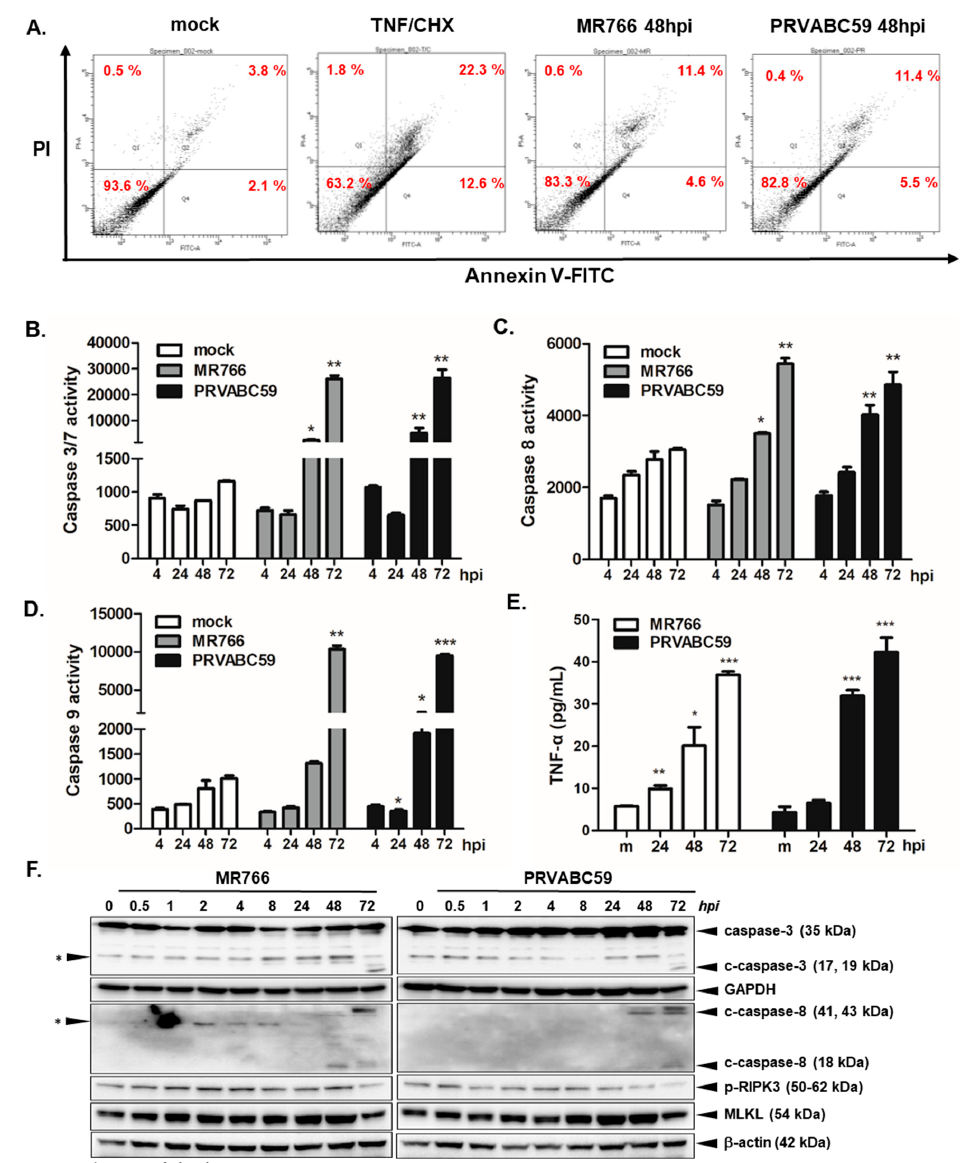
Figure 2. Caspase activity during Zika virus (ZIKV) infection of hNPCs. hNPCs were either stimulated with TNF- α and cycloheximide (TNF/CHX) or infected with mock or ZIKV at MOI of 3. ( A ) Flow cytometry analysis by AnnexinV5-FITC/PI staining shows % cells undergoing apoptosis. Activity of caspases 3/7 ( B ), 8 ( C ), and 9 ( D ) in mock- and ZIKV-infected cultures was determined using caspase luminescence assays after 24, 48, and 72 hpi. Data represented as mean ±SD. (* p < 0.05; ** p < 0.01; *** p < 0.001, compared with mock control). ( E ) TNF- α secretion level from ZIKV-infected hNPCs was measured by ELISA assay. * p < 0.05; ** p < 0.01; *** p < 0.001 versus mock-infected control cells. ( F ) hNPCs were infected with ZIKV at an MOI of 3 for the indicated times. The cleavage of caspase 3 and caspase-8, phosphorylated RIPK3, and MLKL protein level is shown by western blot analysis. The images are representatives of three independent experiments.